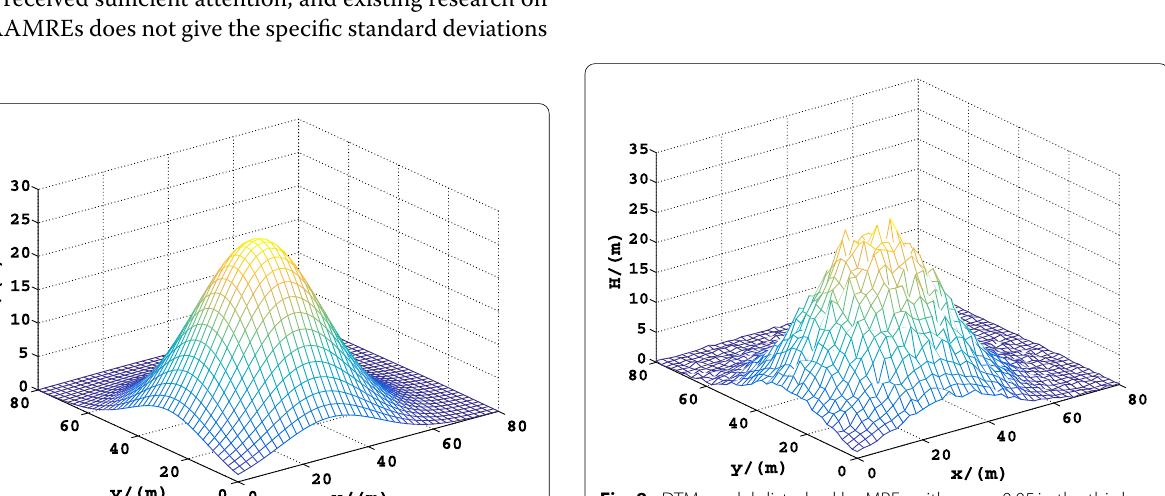
Fig. 8 DTM model disturbed by MREs with σ m = 0.05 in the third